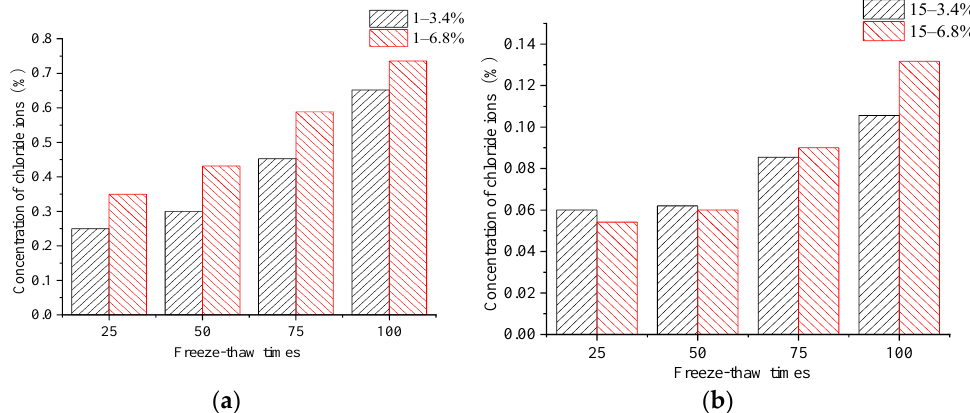
Figure 6. Mass percentage of chloride ions at two depths for various numbers of freeze – thaw cycles. ( a ) 1 mm from the erosion surface. ( b ) 15 mm from the erosion surface. It can be seen that the growth rate of the CIC at the erosion surface of the concrete samples was high for various numbers of FTCs in salt solutions, but that growth rate grad- ually slowed as the depth under the surface increased. The CIC in concrete specimens under FTCs in the 6.8% composite salt solution was larger than concrete specimens under FTCs in the 3.4% composite salt solution. The CIC at a depth of 1mm from the erosion surface was 40% larger after 50 FTCs and 13% larger after 100 FTCs, and the CIC at a depth FTCs. The rate of the CIC increasing at a depth of 15 mm under 25 and 50 FTCs in both